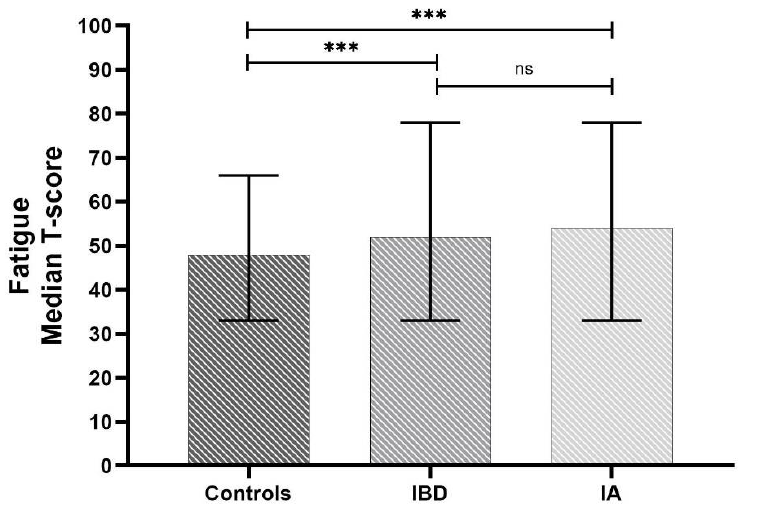
Figure 1. Fatigue in IMIDs patients (IBD: Inflammatory Bowel Disease, IA: Inflammatory Arthritis) as measured by PROMIS ® scales. Data are presented as median and range. The p -values were calculated by the Kruskal-Wallis non-parametric test for independent samples, Bonferroni correction. (*** p < 0.001; ns: non-significant).